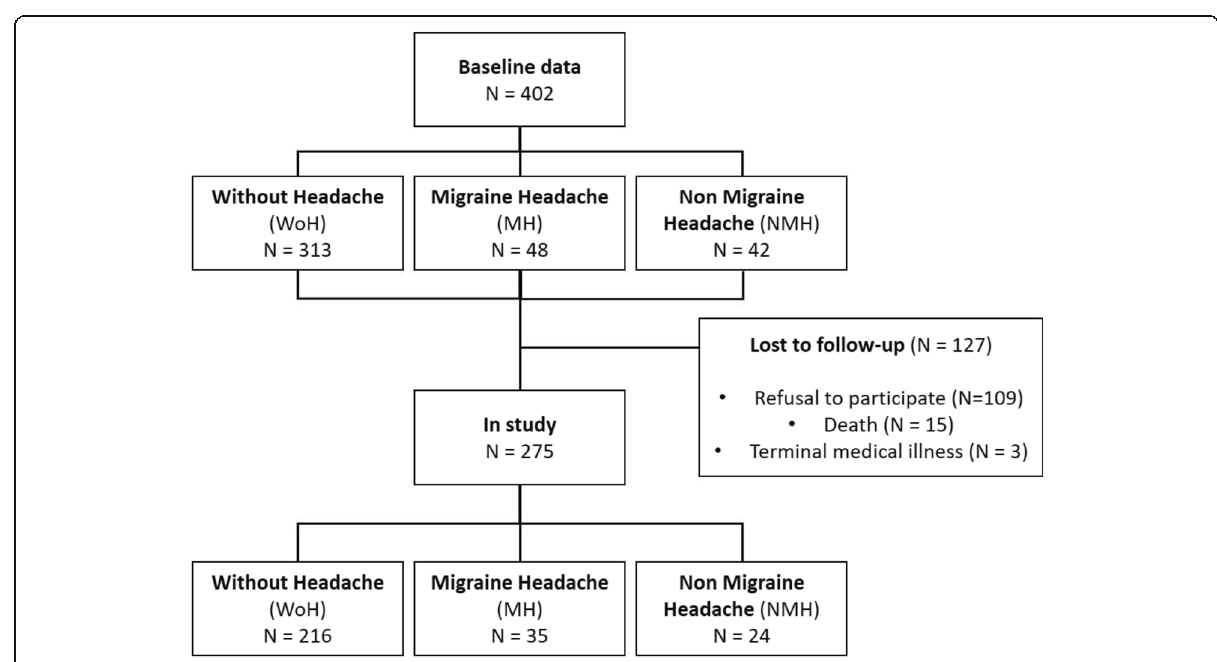
Fig. 1 Flowchart of study participants from baseline to